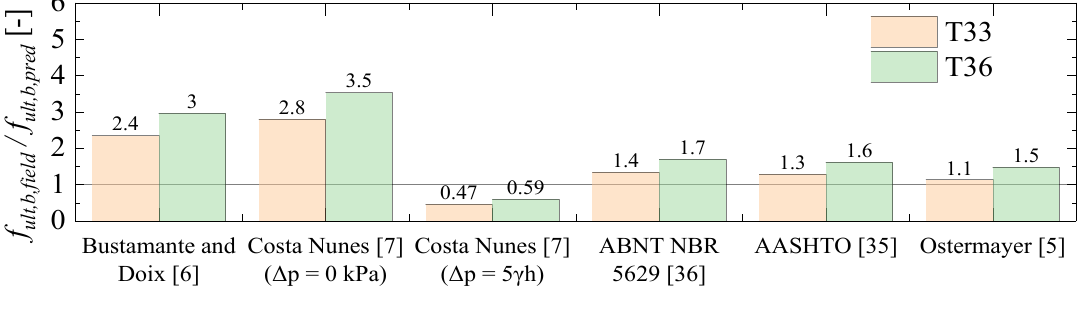
Figure 19 - Comparison between field and predicted ultimate skin friction on bonded length of anchors T33 and